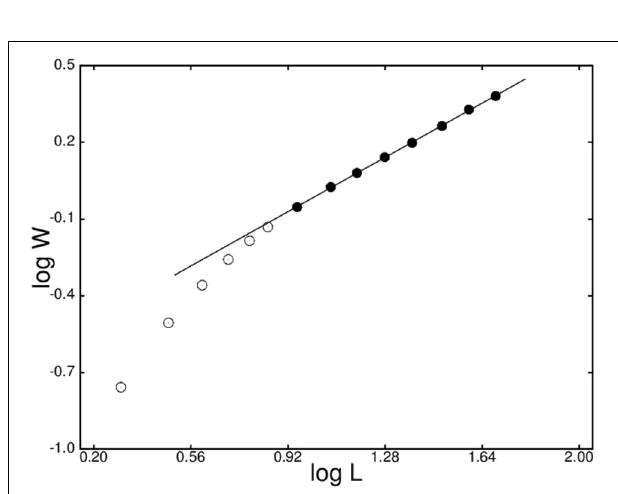
FIGURE 4 | Logarithmic plot, showing the roughness, W , as a function of the system size, L , for disorder D = 4. Black circles denote those points to which the straight line, with slope ζ = 0 . 590(4), has been fitted. The errors on the points are smaller than the size of the points.